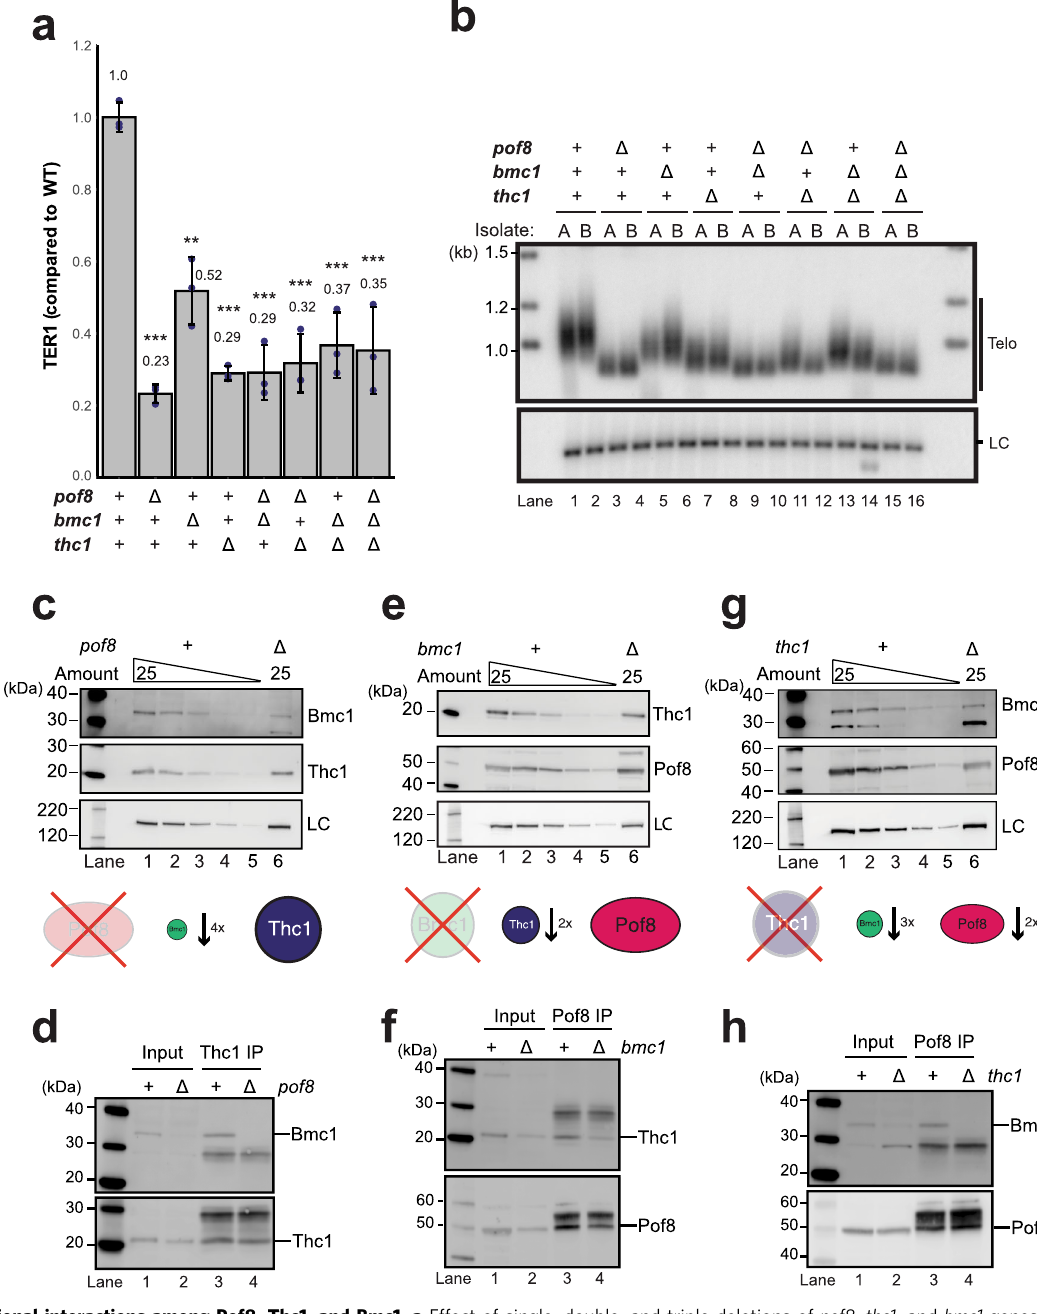
Fig. 4 Functional interactions among Pof8, Thc1, and Bmc1. a Effect of single, double, and triple deletions of pof8 , thc1 , and bmc1 genes on TER1 levels measured by RT-qPCR. Mean (±SD, n = 3) fold-change values relative to wild type (WT). Signi fi cant differences from WT are marked above each bar (two-sided Dunnett ’ s test; *** p < 0.001, **0.001 ≤ p < 0.01, *0.01 ≤ p < 0.05). b Telomeric Southern blot of the strains used in a . Two independent isolates of each deletion are shown. The rad16 + locus was used as a loading control (LC). c Pof8 stabilizes Bmc1. Western blot analysis for Bmc1-Twinstrep and Thc1-2xV5 from 25 µ g of extract of a pof8 Δ strain and a twofold serial dilution of extract from a pof8 + control strain using anti-strep-tag II and anti-V5 antibodies. An unknown protein recognized by the anti-strep-tag II antibody was used as a loading control (LC). d Pof8 is required for the Thc1 – Bmc1 interaction. Western blot analysis of co-immunoprecipitation using anti-V5 in strains containing Bmc1-Twinstrep and Thc1-2xV5 in pof8 + and pof8 Δ backgrounds. The blot was probed with anti - Strep-tag II antibody for Bmc1-Twinstrep ( top ) and reprobed with anti-V5 antibody for Thc1-2xV5 ( bottom ). Input represents 10% of IP. e Bmc1 stabilizes Thc1. Assessment of steady-state protein levels as in c for Thc1-2xV5 and 3xFLAG-Pof8 following the deletion of bmc1 . f Bmc1 is not required for Thc1 – Pof8 interaction. Western blot analysis of co-IP using anti-FLAG antibody in strains containing 3xFLAG-Pof8 and Thc1-2xV5 in bmc1 + or bmc1 Δ backgrounds. The blot was probed with anti-V5 antibody for Thc1-2xV5 (top) and reprobed with anti-FLAG for 3xFLAG-Pof8 (bottom). g Thc1 stabilizes Bmc1 and Pof8 protein. Assessment of steady-state protein levels as in c for Bmc1-Twinstrep and 3xFLAG-Pof8 following the deletion of thc1 . h Thc1 is required for the Pof8-Bmc1 interaction. Western blot analysis of co-IP using anti-FLAG in strains containing 3xFLAG-Pof8 and Bmc1-Twinstrep in thc1 + or thc1 Δ backgrounds. The blot was probed with anti-Strep-tag II for Bmc1-Twinstrep (top) and reprobed with anti-FLAG for 3xFLAG-Pof8 (bottom).